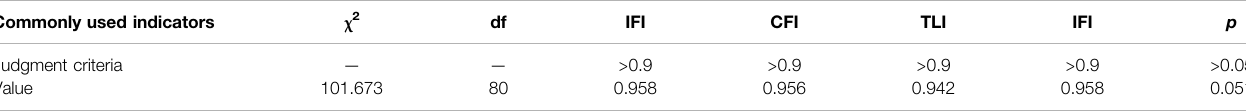
TABLE 6 | Model fi tting indicators.